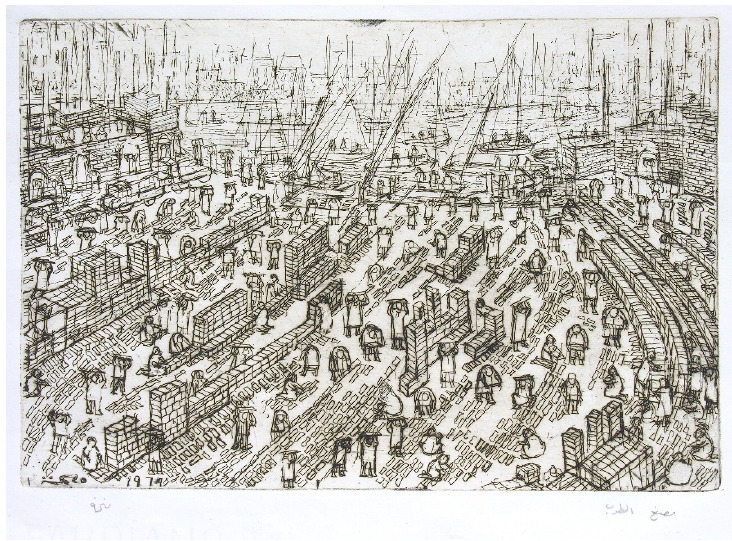
Figure 19. Menhat Helmy, Brick Factory. (1969) Etching.